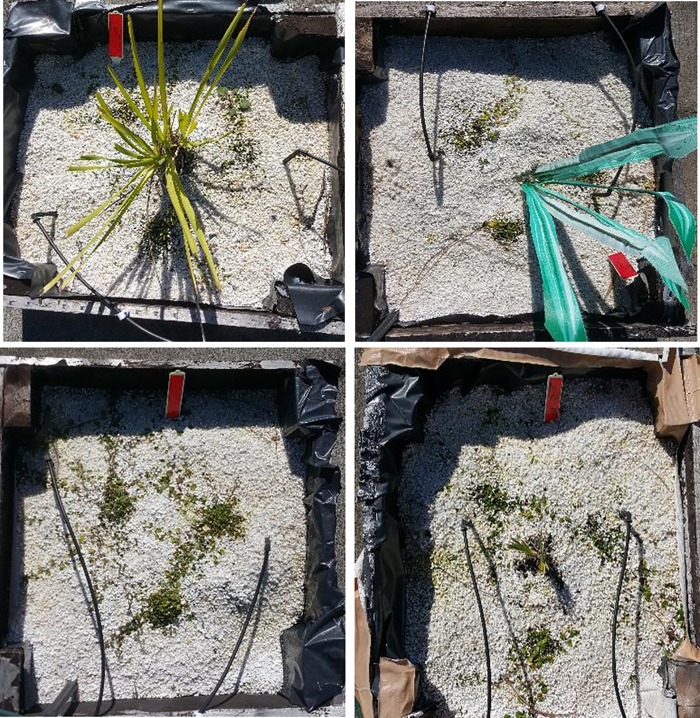
Pictorial representation of the 4 treatments used in the experiment.Treatments: from the top left in a clockwise direction, shaded natural, shaded artificial, unshaded natural, unshaded (example of Lomandra longifolia and Dichondra repens pair).